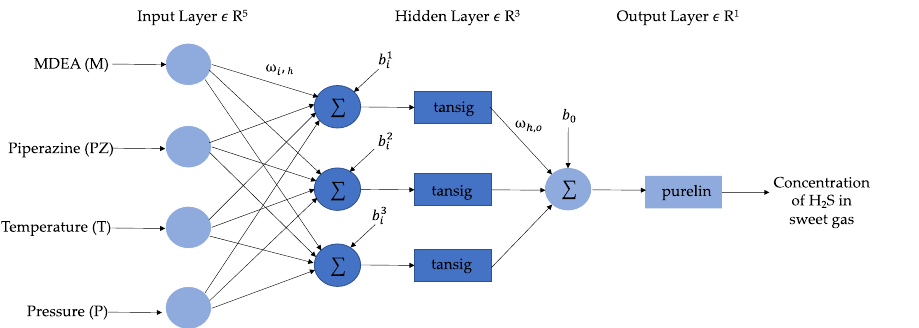
Figure 4. Feedforward neural network developed in this